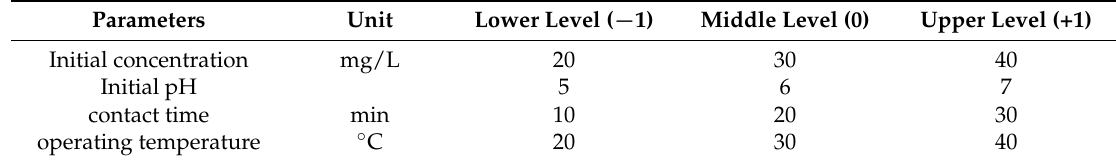
Table 1. Independent variables and their levels for RSM modeling and